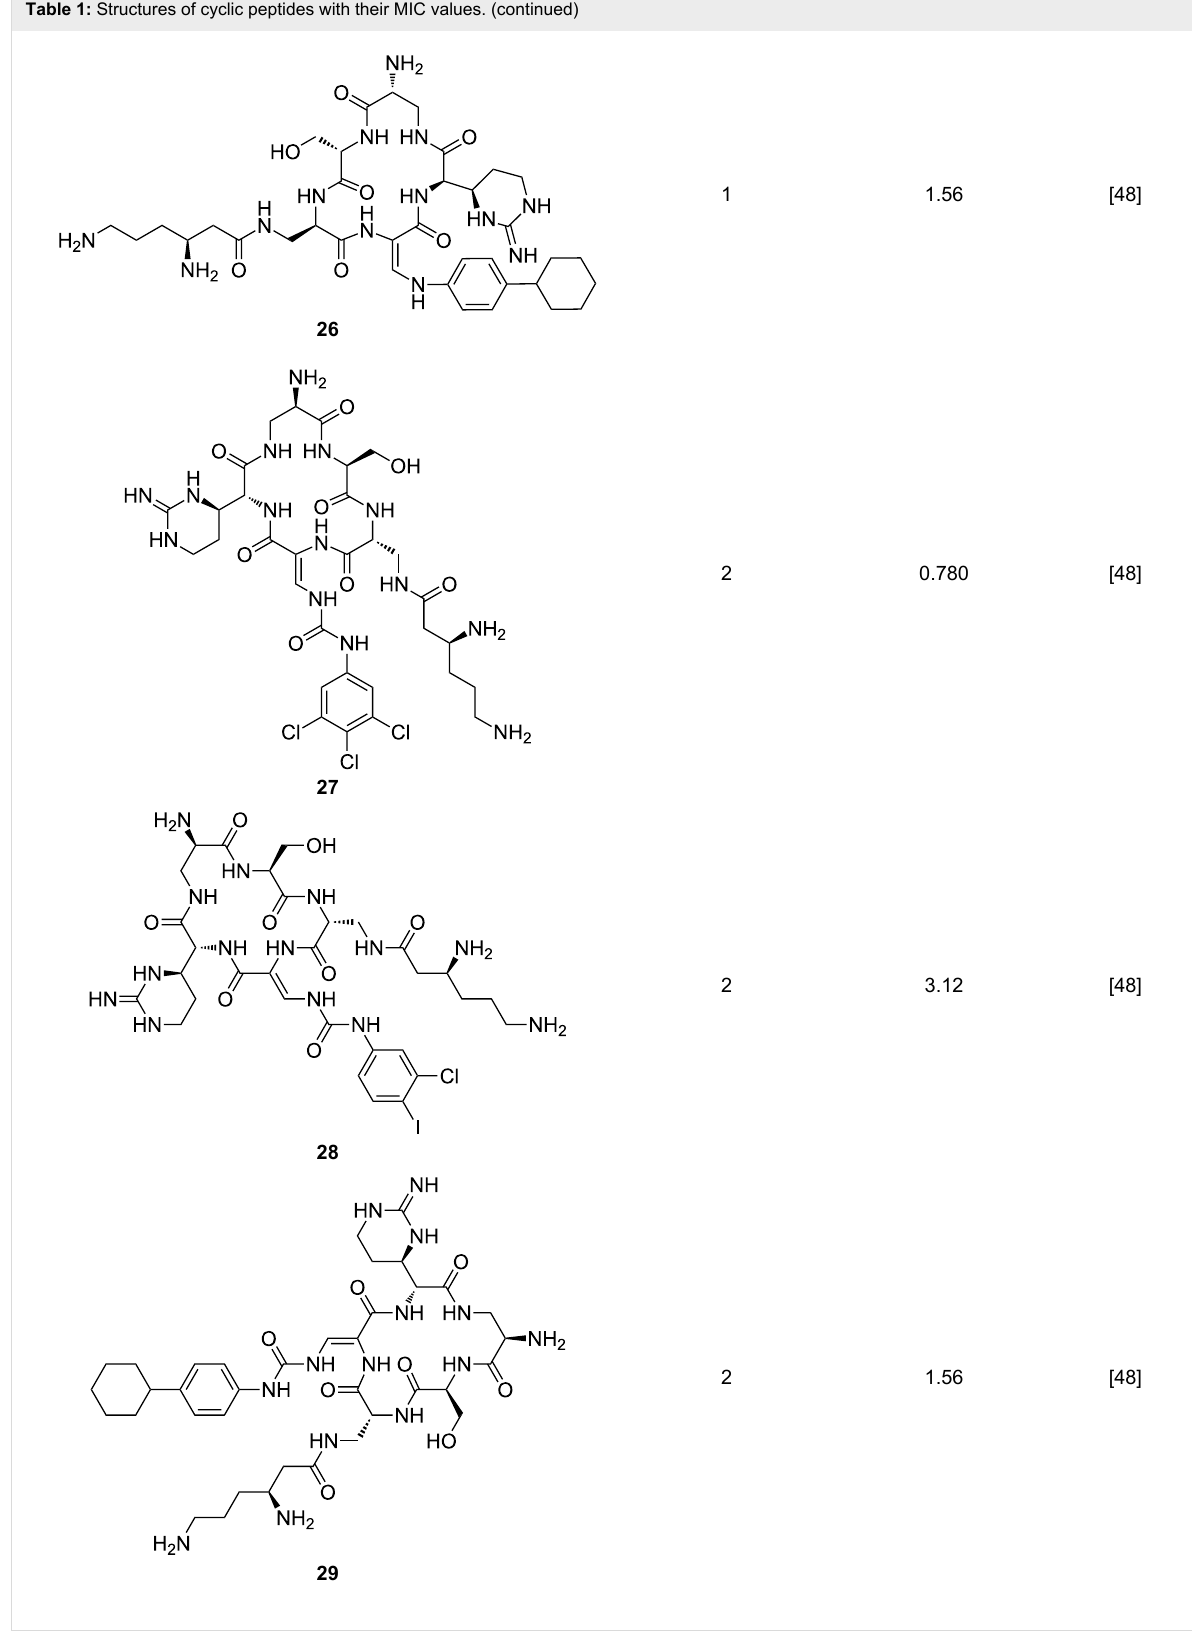
Table 1: Structures of cyclic peptides with their MIC values.